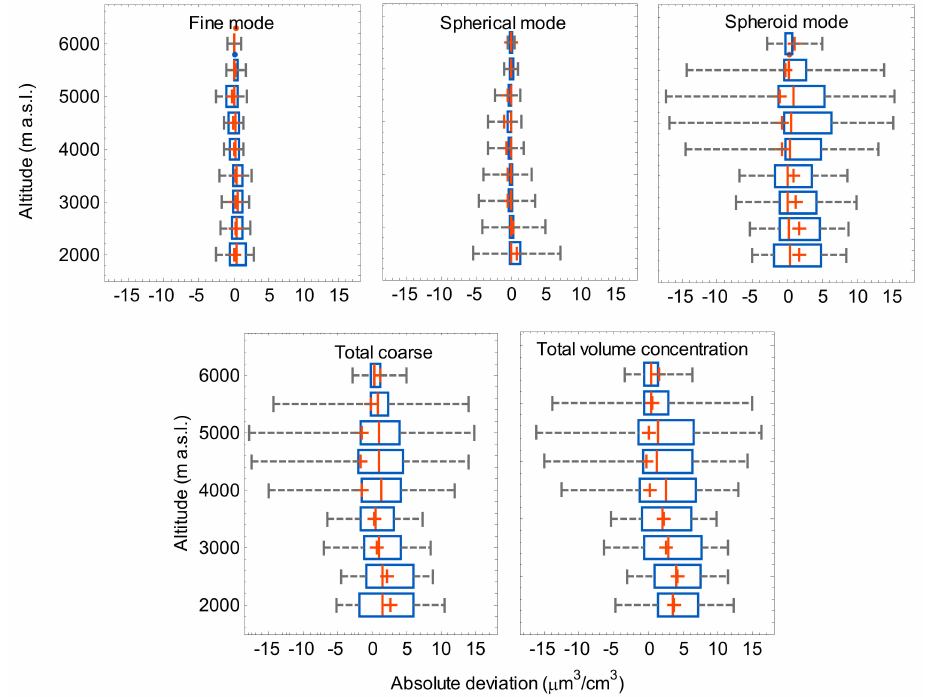
Figure 6. Box-and-whisker plots of the deviation profiles distributed in 500-m layers for fine, coarse spherical, coarse spheroid, total coarse mode and the total volume concentration. Deviations are obtained by subtracting the retrieved volume concentration profiles from Granada above 1820 m a.s.l. to those retrieved from Cerro Poyos at every height level (15 m vertical